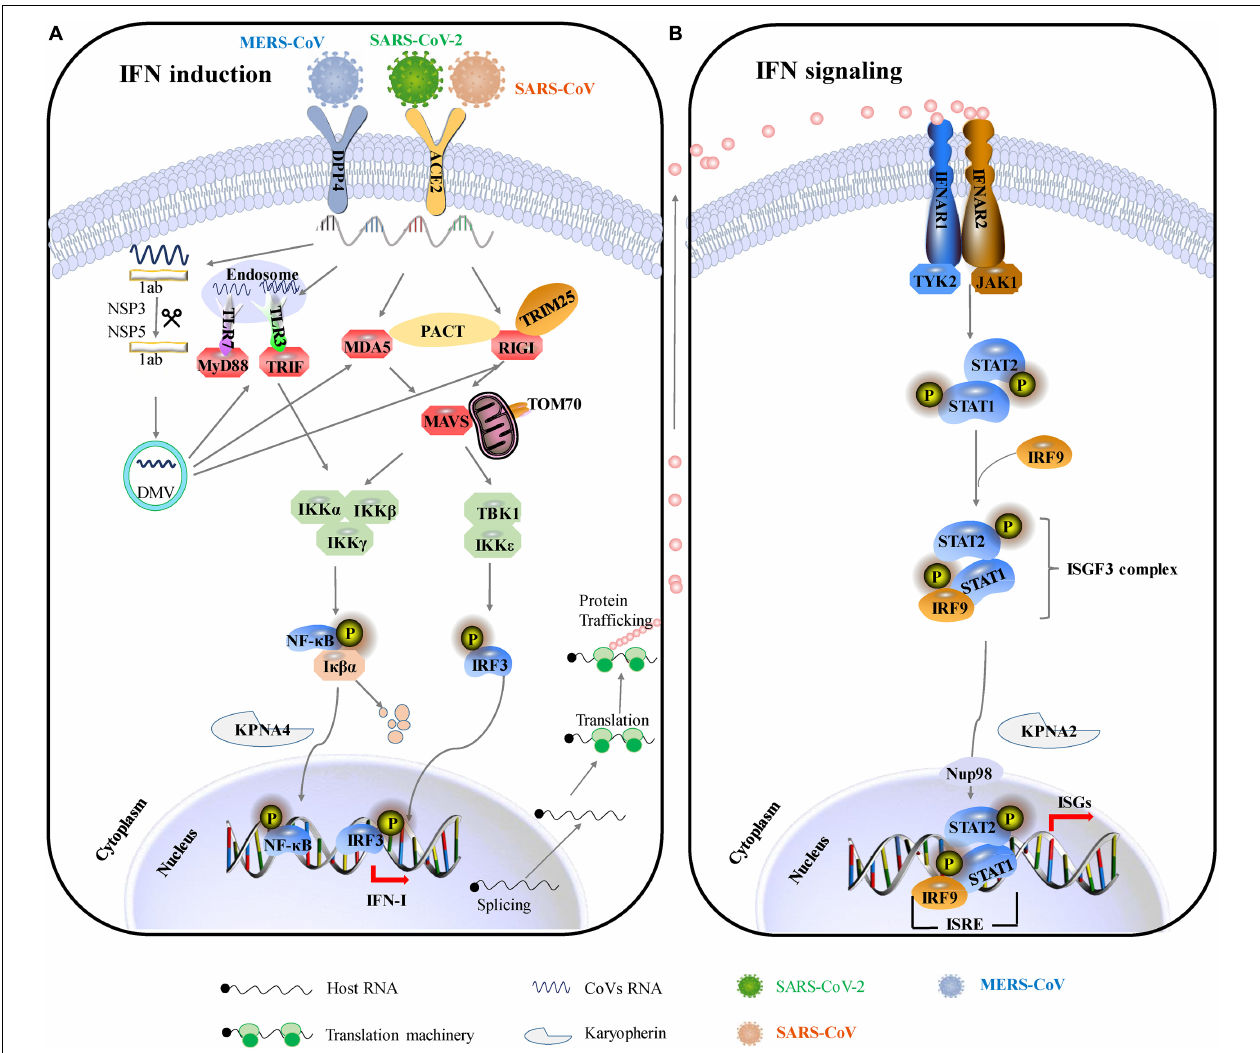
FIGURE 2 | IFN-mediated antiviral responses. (A) SARS-CoV and SARS-CoV-2 use the same receptor ACE2 for host cellular entry, while MERS-CoV utilizes DPP4 for host cellular entry. They are most likely recognized by PRRs, including cytoplasmic RIG-I and MDA5 and by endosomal TLR3 and TLR7. RIG-I/MDA5 conveys signal through a mitochondrial adaptor MAVS, while TLR signals through TRIF/MyD88. Subsequently, activating the shared downstream kinases and transcription factors. Both pathways can activate the key transcription factors (IRF3 and NF- κ B) phosphorylation and subsequent dimerization, which are translocated into the nucleus to promote IFN-I expression. (B) IFNs bind to the heterodimeric receptor complexes IFNAR1/IFNAR2, initiating JAK/STAT signaling. Receptor-associated tyrosine kinases Jak1 and Tyk2 are triggered for self-phosphorylation and activation, leading to the phosphorylation of STATs. Phosphorylated STAT1/2 with IRF9 forms a complex ternary ISGF3 (STAT1/STAT2/IRF9), which translocates into the nucleus and binds to IFN-stimulated response elements (ISREs), promoting the transcription of hundreds of IFN-stimulated genes (ISGs). ACE2, angiotensin-converting enzyme 2; DPP4, dipeptidyl peptidase 4; DMVs, double-membraned vesicles; RIG-1, retinoic acid-inducible gene I; MDA5, melanoma differentiation-associated protein 5; MyD88, myeloid differentiation primary response 88; TRIF, TIR-domain-containing adapter-inducing IFN- β ; MAVS, mitochondria antiviral signaling protein; PACT, protein activator of protein kinase R; I κβα , inhibitor of NF- κ B; IRF3, interferon regulatory factor 3; TBK1, TANK-binding kinase 1; IKK ε , I-kappa-B kinase ε ; Nup93, nuclear pore complex protein 93; KPNA4, karyopherin- α 4; KPNA2, karyopherin- α 2; ISGF3, IFN-stimulated gene factor 3; IFNAR1, interferon-alpha/beta receptor alpha chain KPNA2, karyopherin- α 2; ISG, interferon gene expression; JAK/STAT, Janus kinases/signal transducer and activator transcription